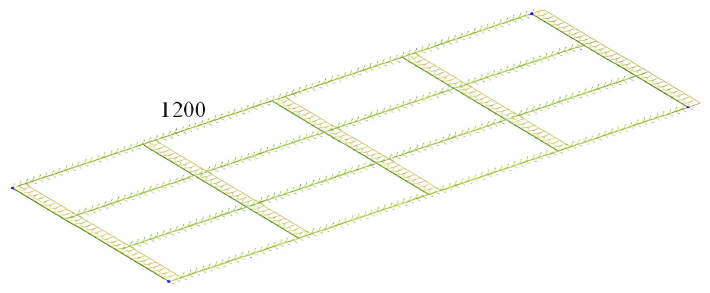
Figure 3. Design diagram of the module at loading Diagram II (kN).